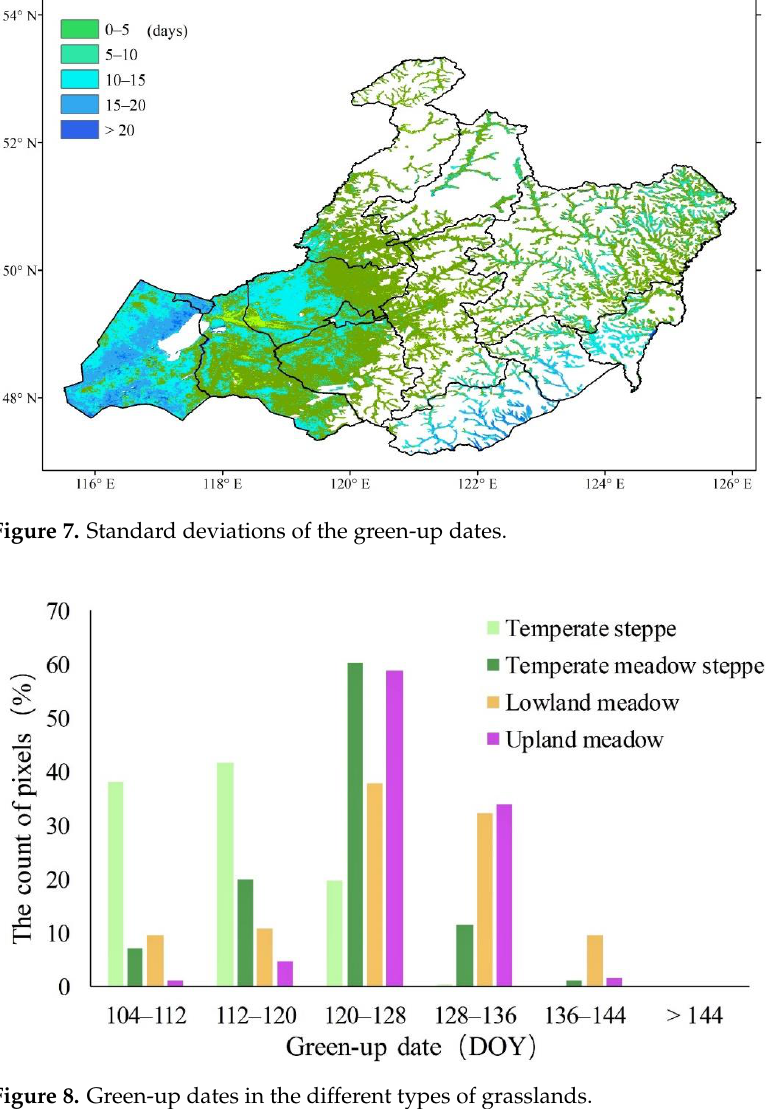
Figure 6. Mean green-up dates between 2001 and 2015.